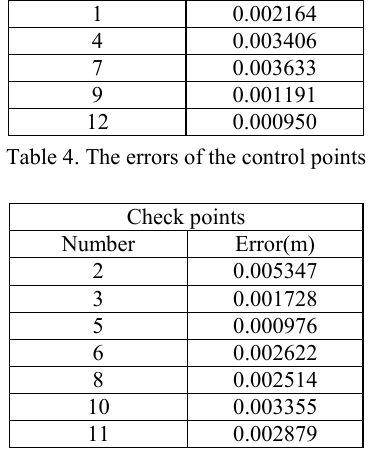
Table 5. The errors of the check points